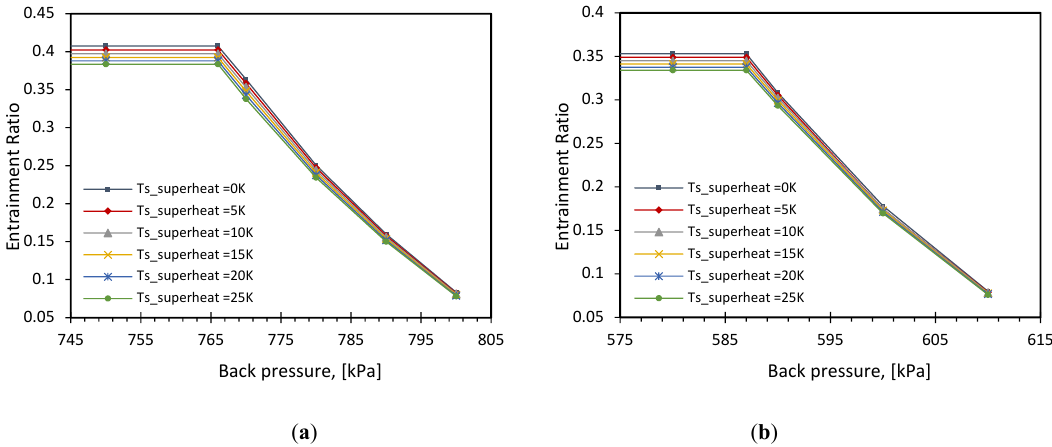
Figure 9. CFD Entrainment ratio vs back pressure for the ejector with superheated secondary flow at T s = 6 °C and T p = 80 °C (a) R1234yf. (b) R1234ze(E).